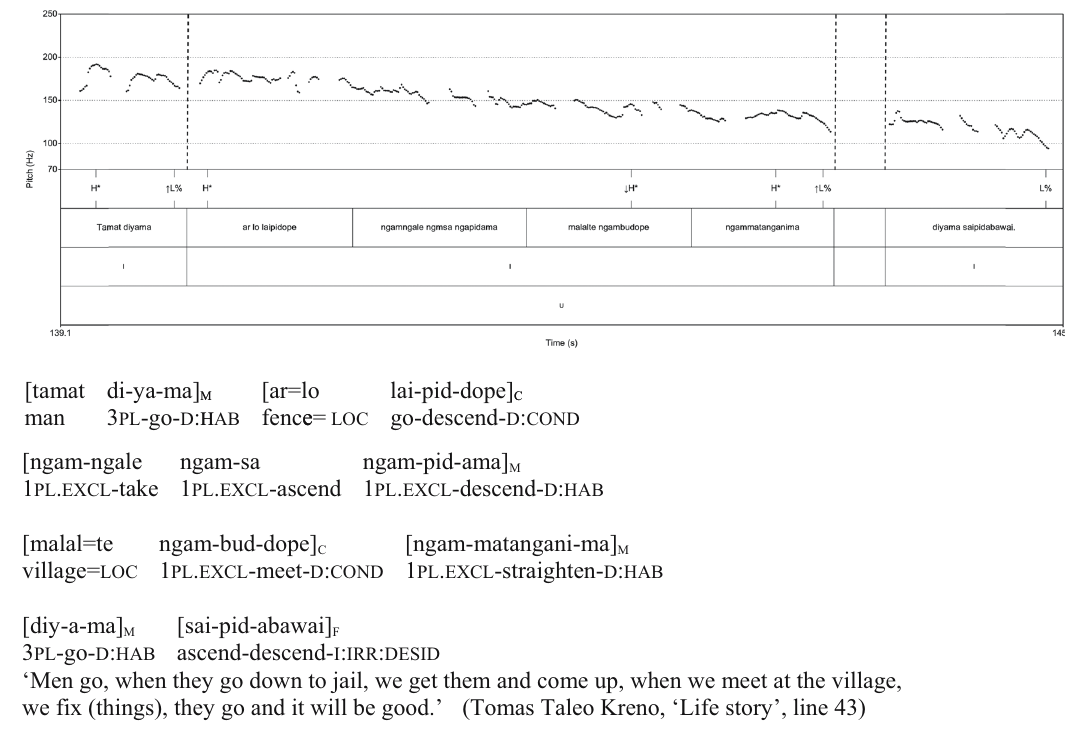
Figure 8: Clause chain both medial and adverbial